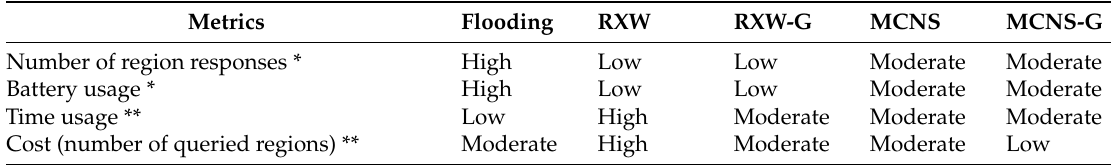
Table 2. Comparing the various